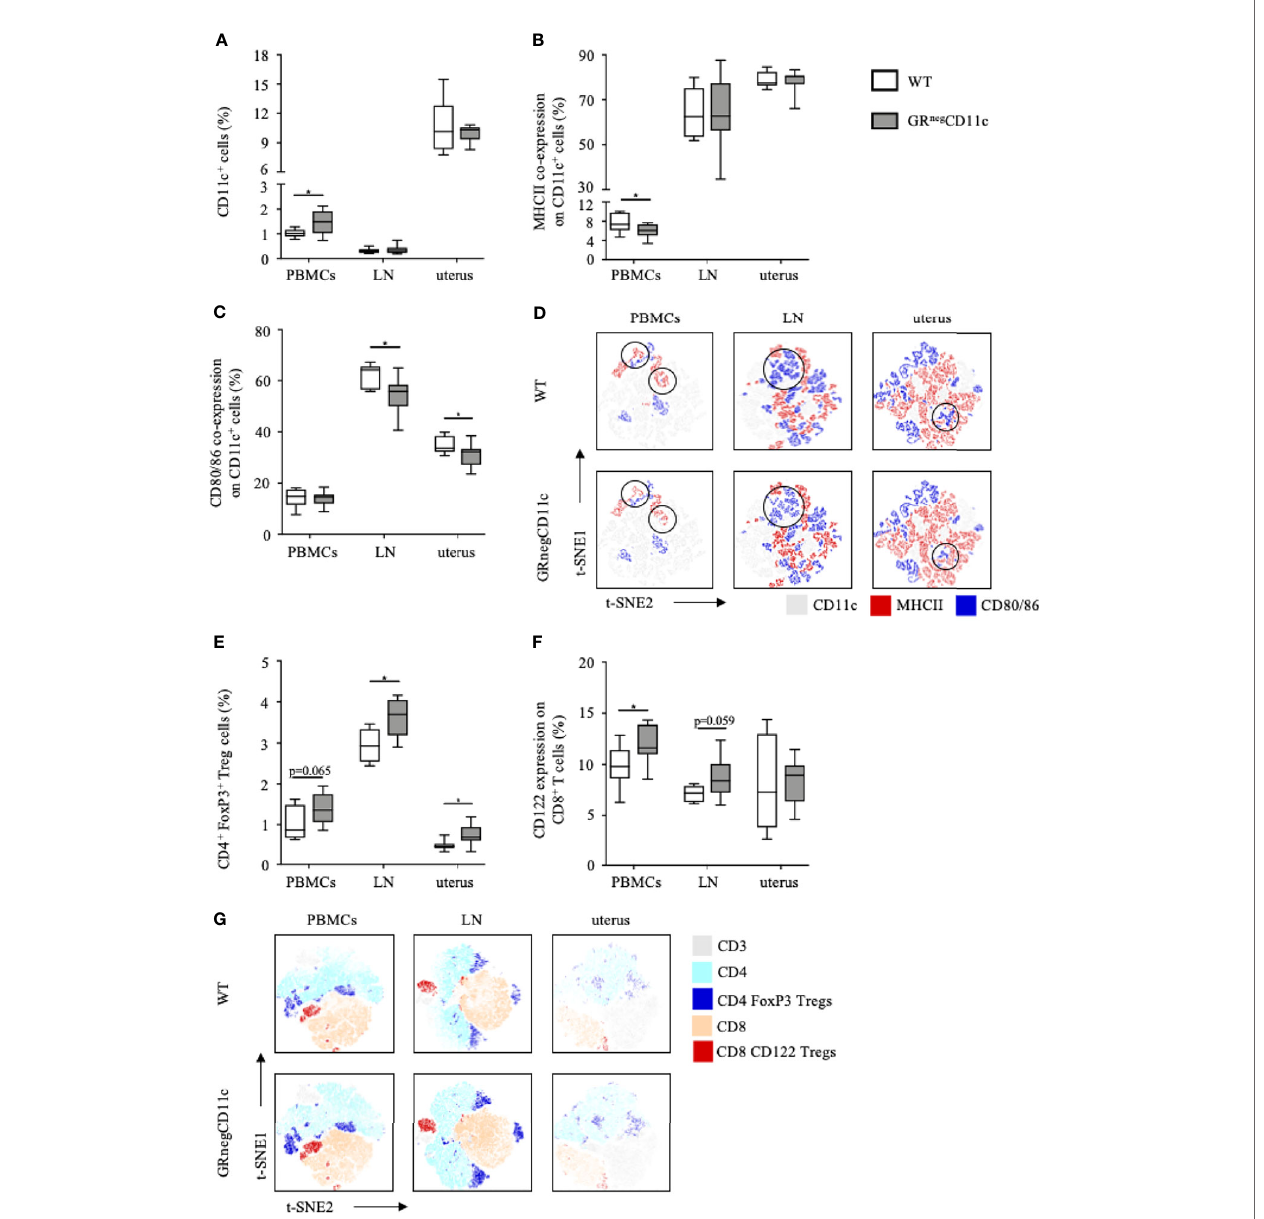
FIGURE 4 | Impaired glucocorticoid-responsiveness of dendritic cells (DCs) bene fi cially affects maternal immune adaption. WT and GRnegCD11c female mice were allogenically mated and fl ow cytometric analysis of peripheral blood mononuclear cells (PBMCs), the uterus-draining lymph node (LN) and the uterus was performed on gestation day 13.5. Box plots present the frequencies of (A) CD11c + DCs, (B) the co-expression of the major histocompatibility complex (MHC) II and (C) CD80 and CD86. Representative tSNE plots are shown in (D) Box plots present the frequencies of CD4 + FoxP3 + Treg cells (E) and CD122 + expression in CD8 + T cells (F) of WT and GRnegCD11c mice. Representative TSNE are shown in (G) Box plots represent mean ± SEM, Student ’ s t test, *p ≤ 0.05, unless otherwise stated, cell frequencies are expressed as percentage of living CD45 +